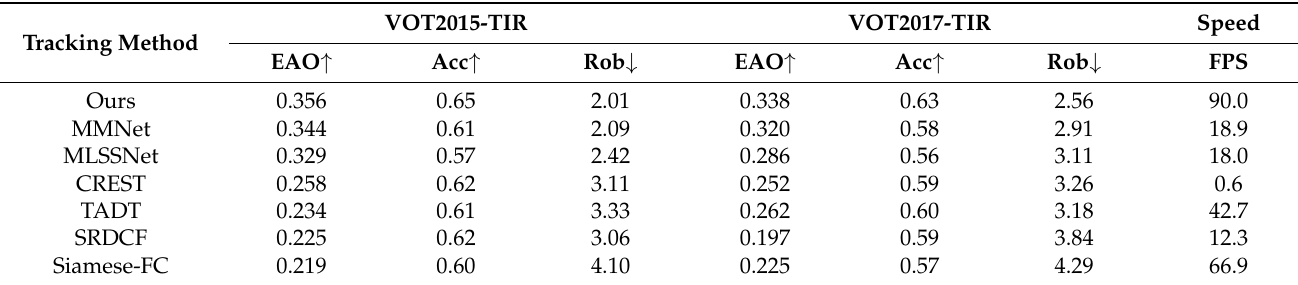
Table 1. Performance comparison with other existing tracking methods on VOT2015-TIR and